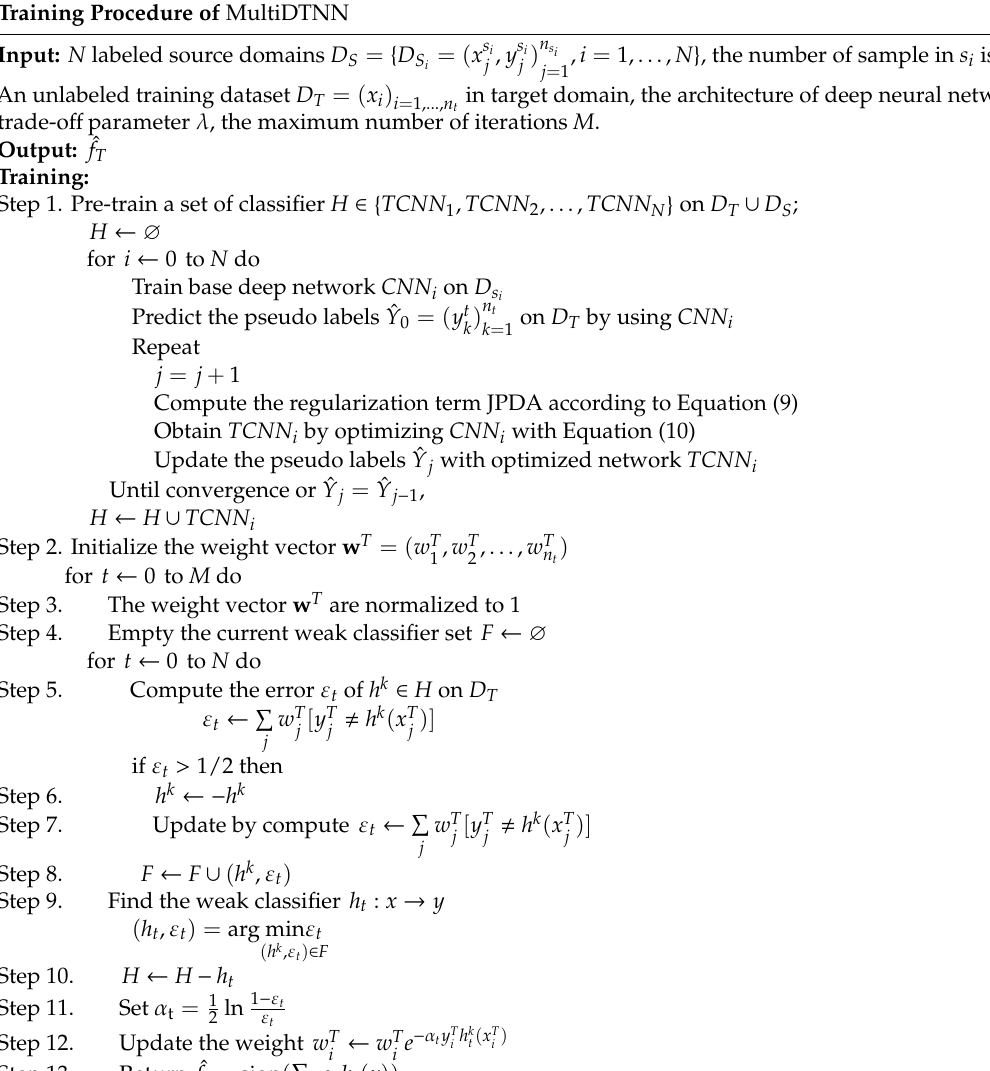
Table 1. Training Strategy of MultiDTNN. Training Procedure of